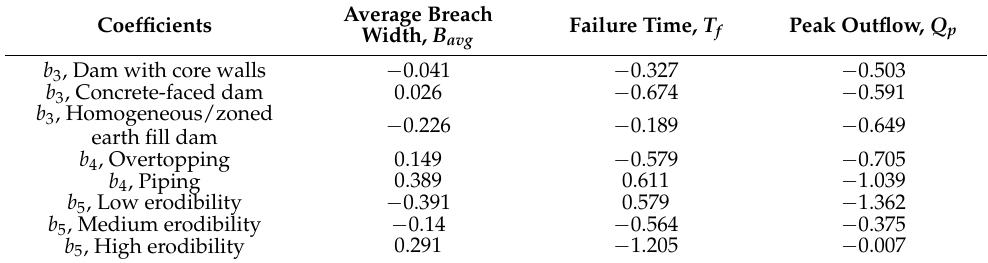
Table A2. Coefficient values of Xu and Zhang’s (2009) [45] empirical